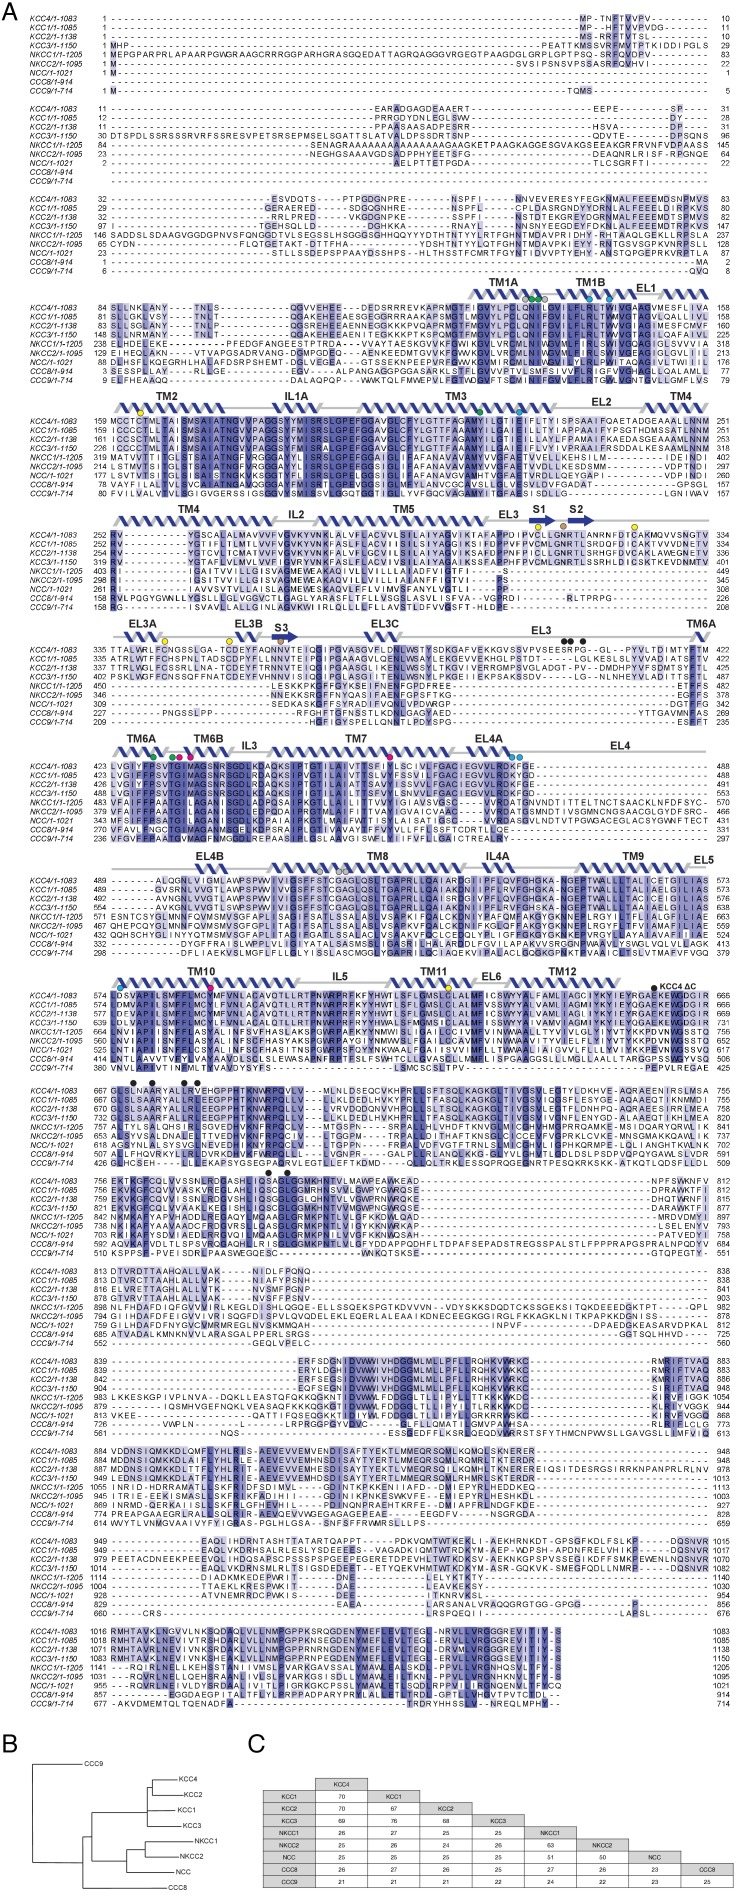
CCC family sequence alignment.(A) Sequence alignment of mouse CCC family transporters. Sequence numbering is indicated at the left and right of each line. Secondary structure for KCC4 is indicated above the sequence. Residues discussed in the text are indicated with circles above the sequence: green, K+ coordinating residues; violet, Cl- coordinating residues; gray, Na+ coordinating residues in NKCC1; yellow, disulfide bond forming residues; brown, glycosylated residues; cyan, extracellular gate forming residues; black, putative dimerization interfaces. (B) Cladogram of CCC family made using sequences from mouse. (C) Percentage sequence identity between members of the mouse CCC family.